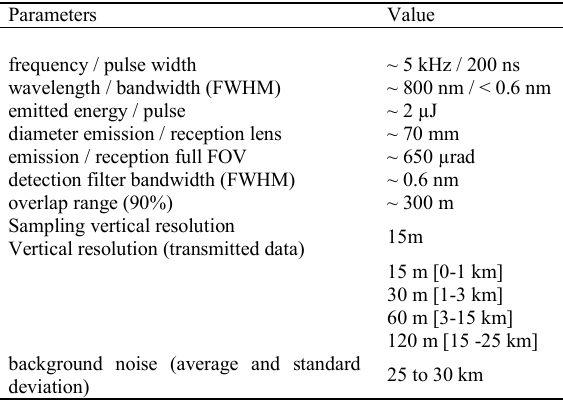
Table 2: Typical IAOOS lidar system parameters Data processing is performed according to